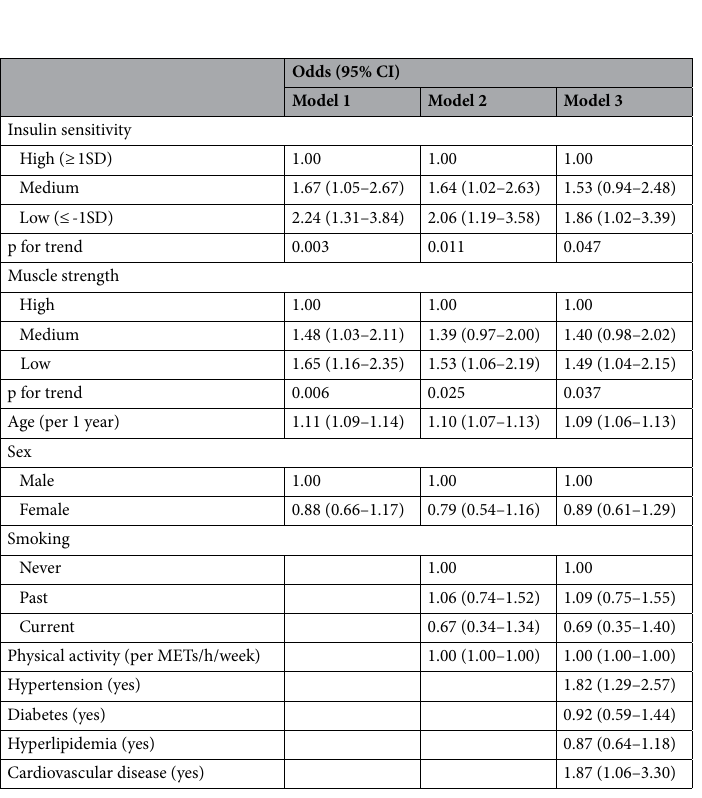
Figure 1. Correlation between insulin sensitivity and muscle strength.